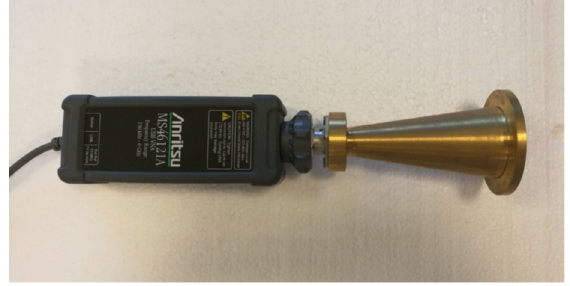
Figure 1. Open‐ended coaxial probe and VNA used during the experiments.